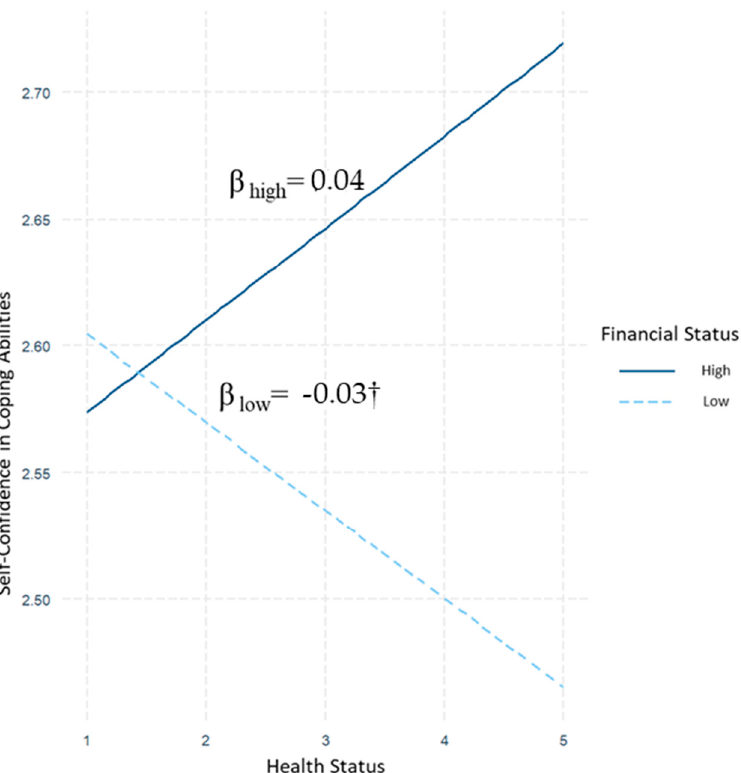
Figure 3. Graph of interaction between financial status and health on confidence in coping abilities. Note. † p < Note. † p < 0.10.